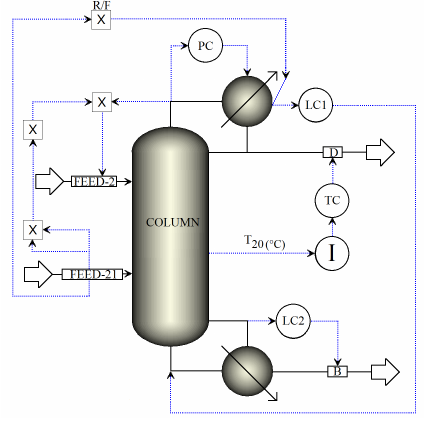
Figure 10. Structure R/F with single tray temperature